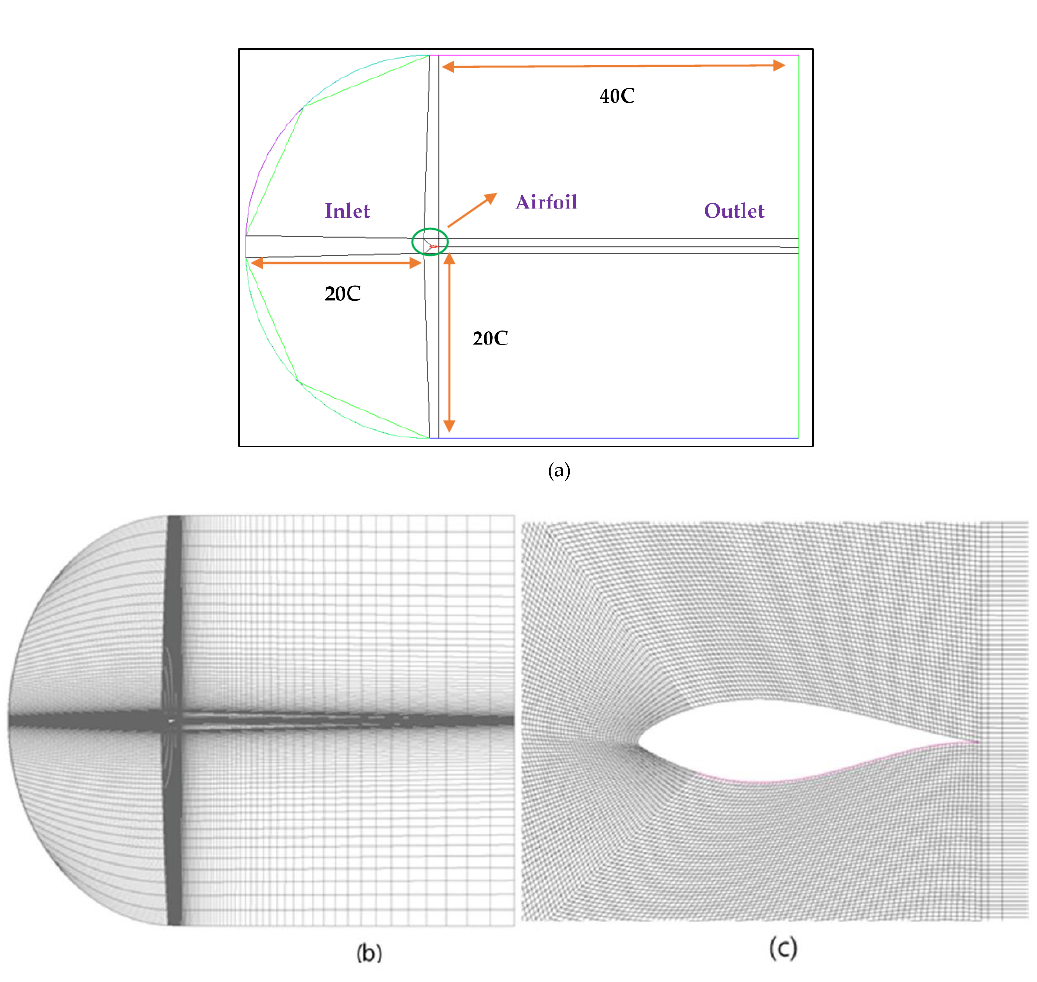
Figure 6. The C-type mesh for the baseline airfoil of a wind turbine at an angle of attack (AOA) of 6.2°. ( a ) Overall blocking structure; ( c ) the mesh; and ( b ) zoomed-in mesh image.